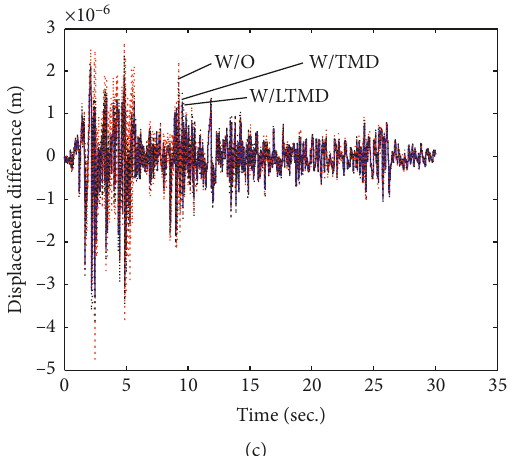
Figure 10: Displacement responses at nodes 10 and 15 ( μ � 0 . 03) of case 1 using α � 1 . 15, β � 1 . 15, c � 0 . 95, and η � 0 . 85. (a) Displacement responses at node 10; (b) displacement responses at node 15; (c) displacement difference between nodes 10 and